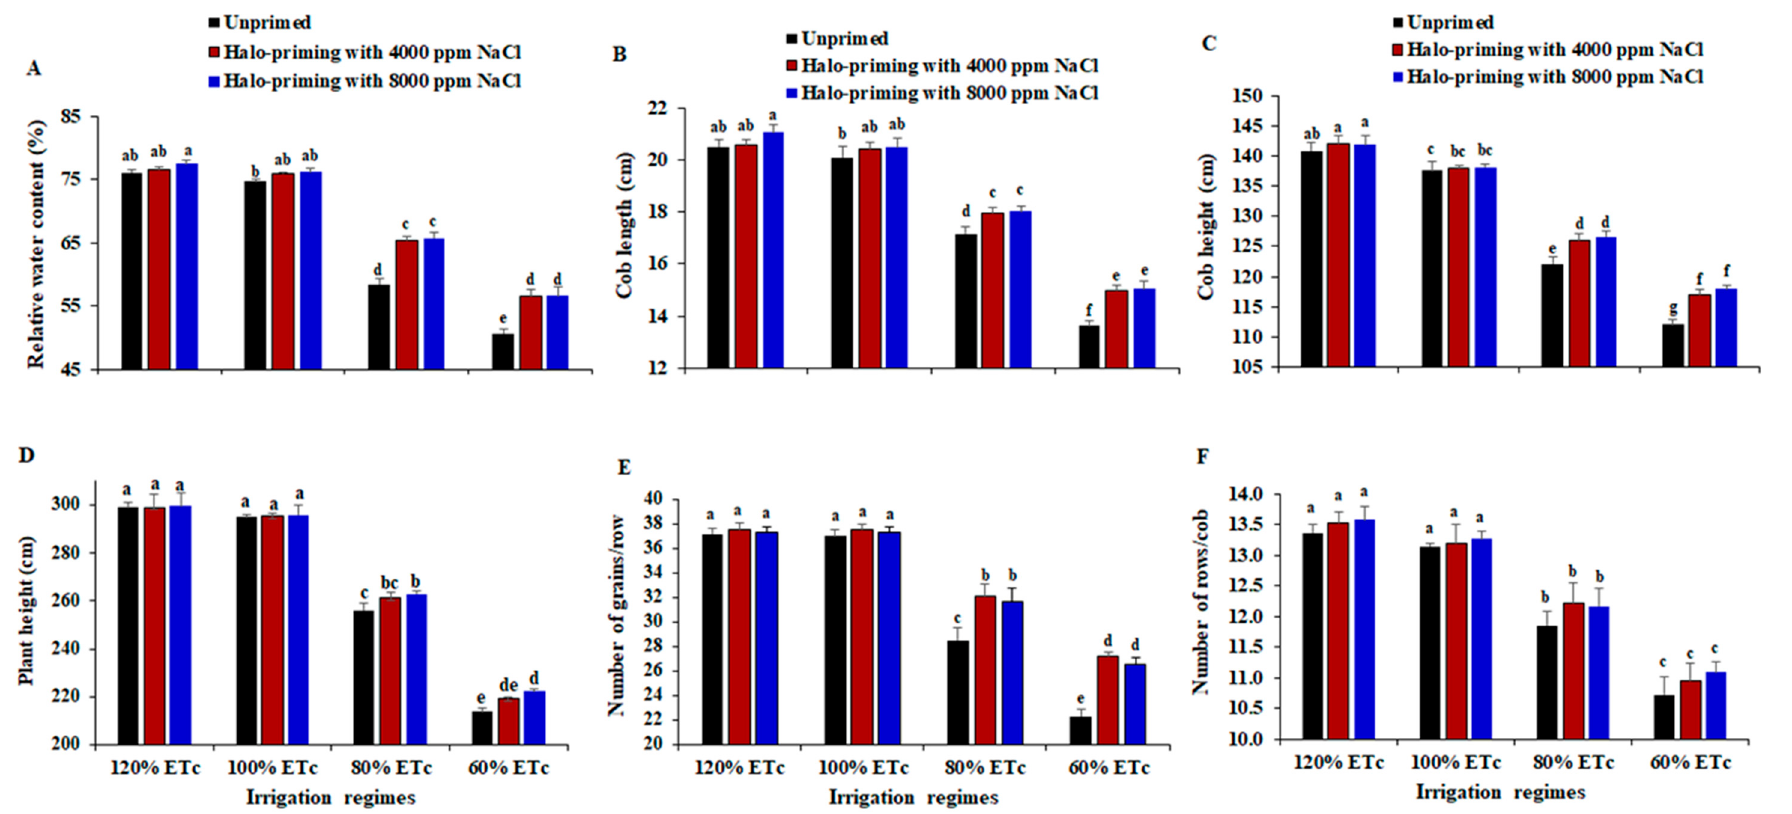
Figure 2. Impact of seed halo-priming treatments on relative water content ( A ), cob length ( B ), cob height ( C ), plant height ( D ), number of grains row − 1 ( E ), and number of rows cob − 1 ( F ) of maize grown under four irrigation regimes over two seasons 2018 and 2019. The bars on the columns correspond to SE and different letters differ significantly by LSD ( p < 0.05).